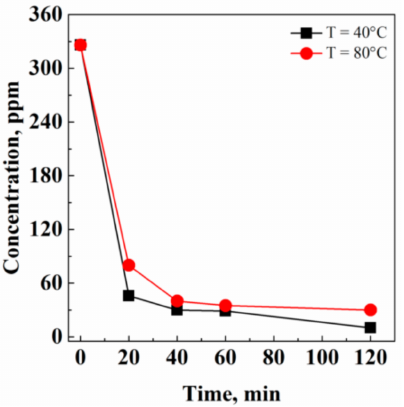
Figure 6. Effect of temperature on acetone residual concentration in Fluti investigated at 200 bar and 0.7 kg/h CO 2 flow